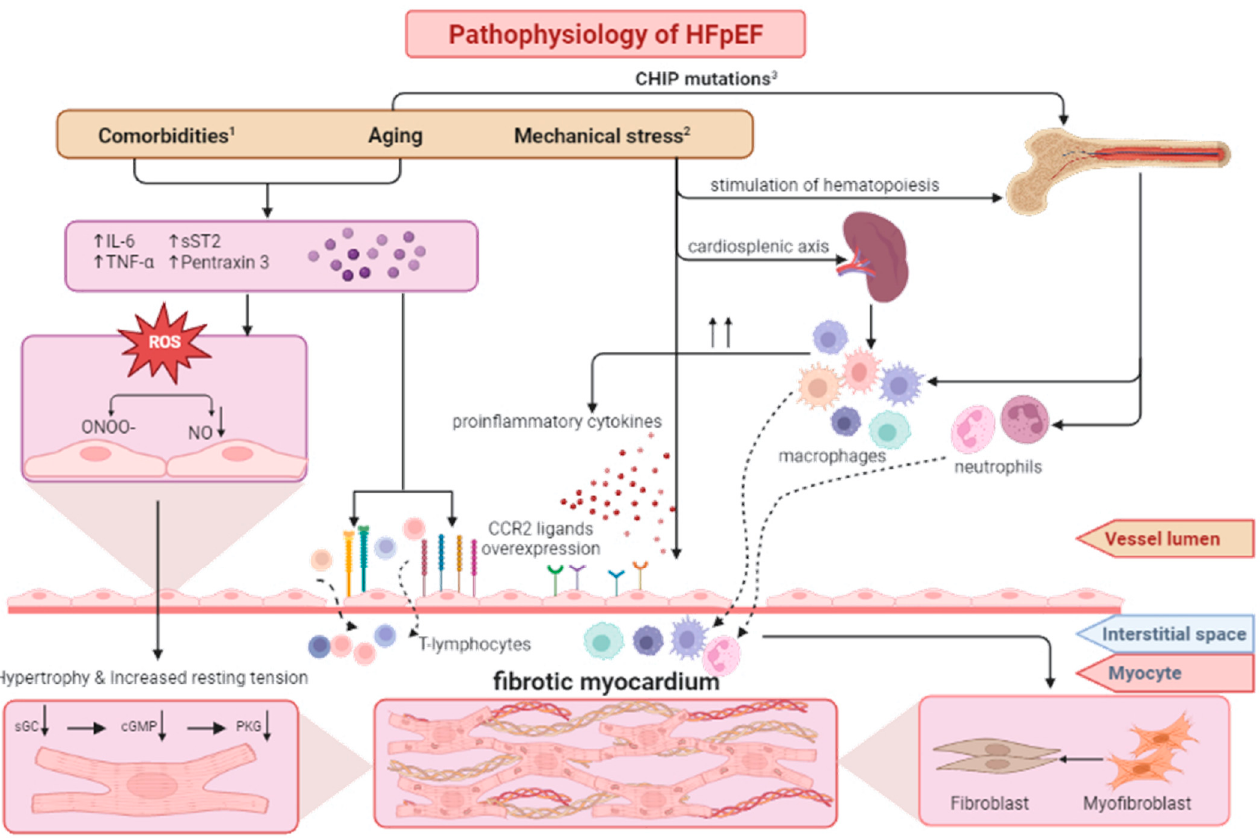
Figure 1. The pathomechanisms of HFpEF associated with 1—comorbidities and aging, 2— mechanical stress, and 3—CHIP mutations, leading to myocardial fibrosis and diastolic dysfunction over the course of HFpEF. Based on [21]. CCR2—C-C chemokine receptor type 2, cGMP—cyclic guanosine-3,5-monophosphate, CHIP—clonal hematopoiesis of indeterminate potential, HFpEF— heart failure with preserved ejection fraction, IL-6—interleukin 6, NO—nitric oxide, ONOO — peroxynitrite, PKG—cGMP-induced protein kinase, sGC—soluble guanylate cyclase, sST2—soluble suppression of tumorigenicity 2, TNF- α —tumor necrosis factor- α